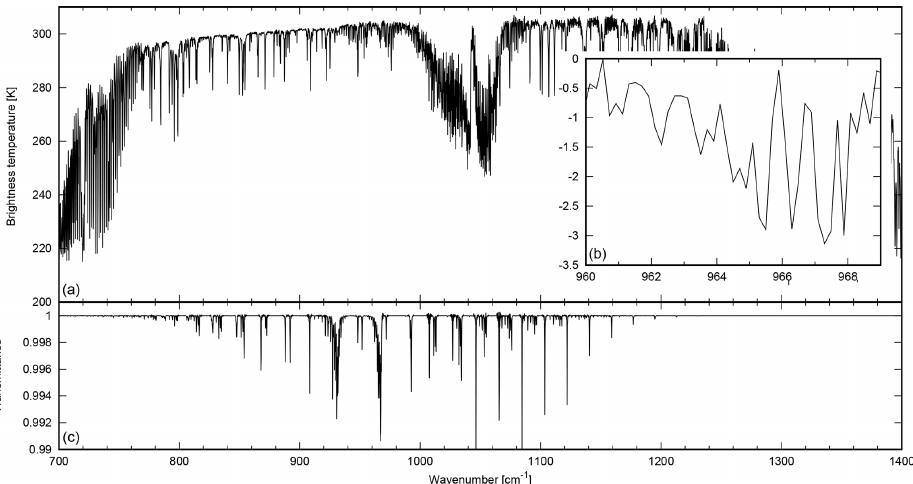
Figure 1. Observed spectra by GOSAT at (75.85 ◦ E, 29.80 ◦ N) on 15 July 2013 (a) , the residuals between the observed spectra and the one calculated without NH 3 (b) , and NH 3 transmittance using the AFGL profile (c) .